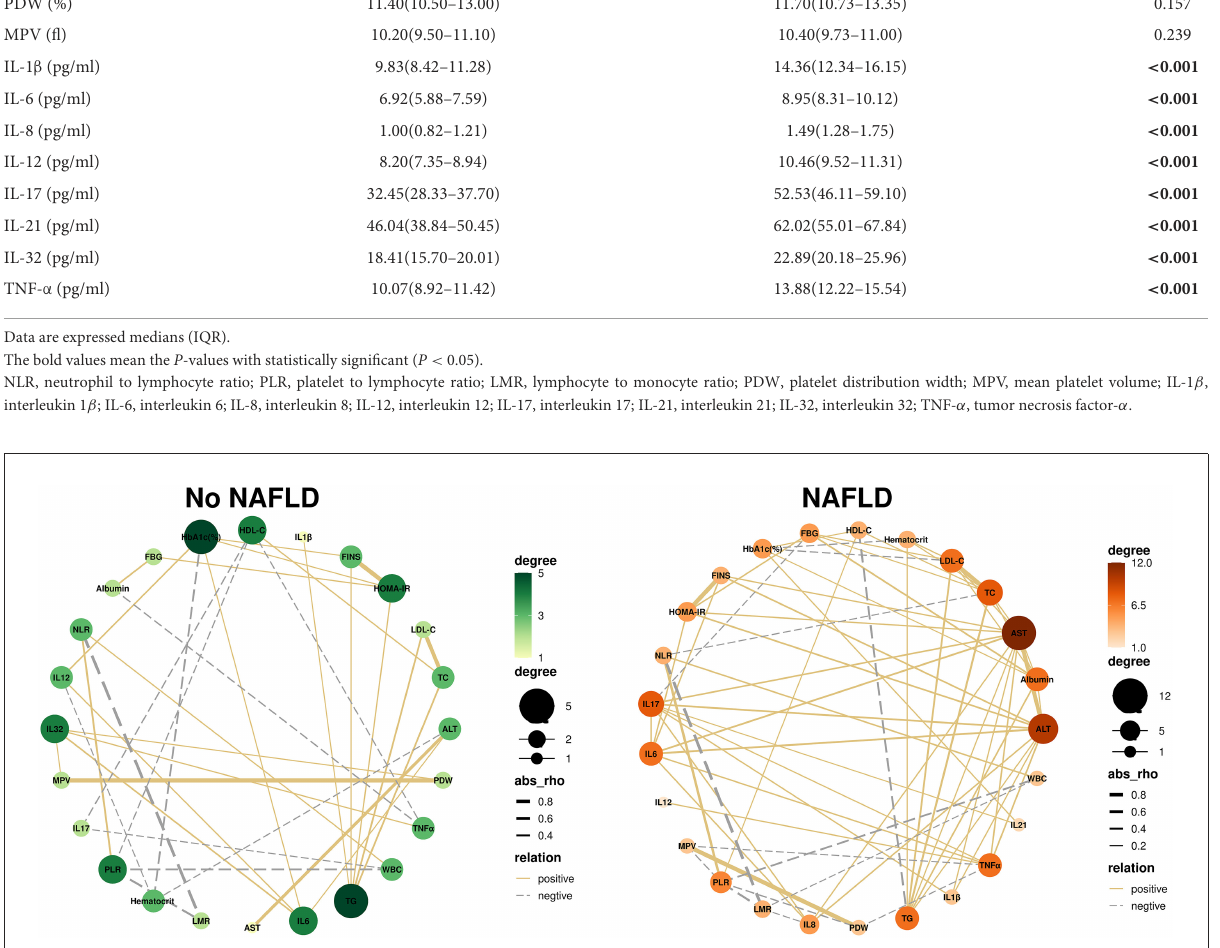
FIGURE1 NAFLD leads to changes in the correlation between inflammatory markers and biochemical parameters. Correlation network analysis was performed on inflammatory markers, plotted against indicators that were significantly correlated ( P < 0.05). Each circle represents a different indicator, the size and color of the circles represent the number of correlations involved for each indicator. The thickness of the line represents the rho value. The solid line represents a positive correlation, while the dashed line represents a negative correlation. TG, triglycerides; TC, total cholesterol; FINS, fasting insulin; HbA1c, glycosylated hemoglobin; HOMA-IR, homeostasis model assessment of insulin resistance; HDL-C, high-density lipoprotein cholesterol; LDL-C, low-density lipoprotein cholesterol; AST, aspartate aminotransferase; ALT, alanine aminotransferase; WBC, white blood cell count; PDW, platelet distribution width; MPV, mean platelet volume; WHR, waist circumference to hip circumference ratio; NLR, neutrophil to lymphocyte ratio; PLR, platelet to lymphocyte ratio; LMR, lymphocyte to monocyte ratio; IL-1 β , interleukin-1 β ; IL-6, interleukin 6; IL-8, interleukin 8; IL-12, interleukin 12; IL-17, interleukin 17; IL-21, interleukin 21; IL-32, interleukin 32; TNF- α , tumor necrosis factor- α